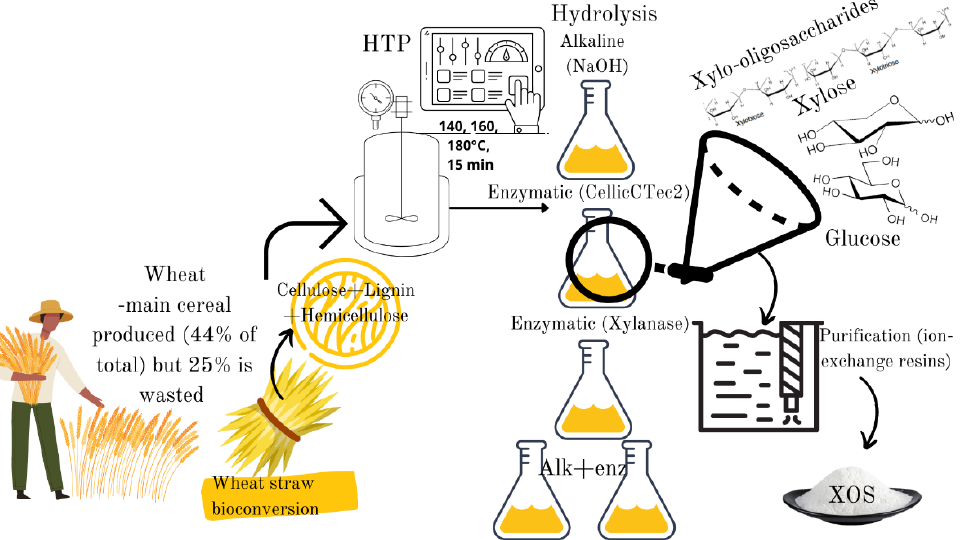
Figure 1. Graphical abstract: Chemical and enzymatic synthesis of biobased xylo-oligosaccharides and fermentable sugars from wheat straw.